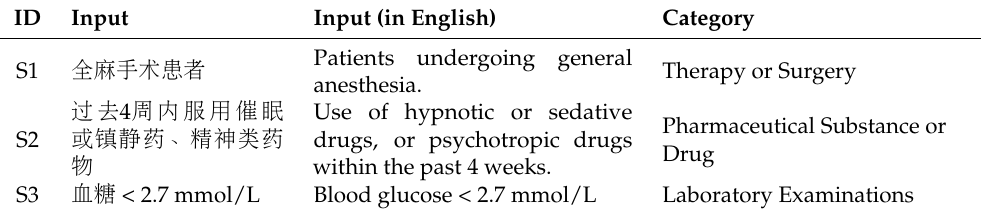
Table 1. Example of